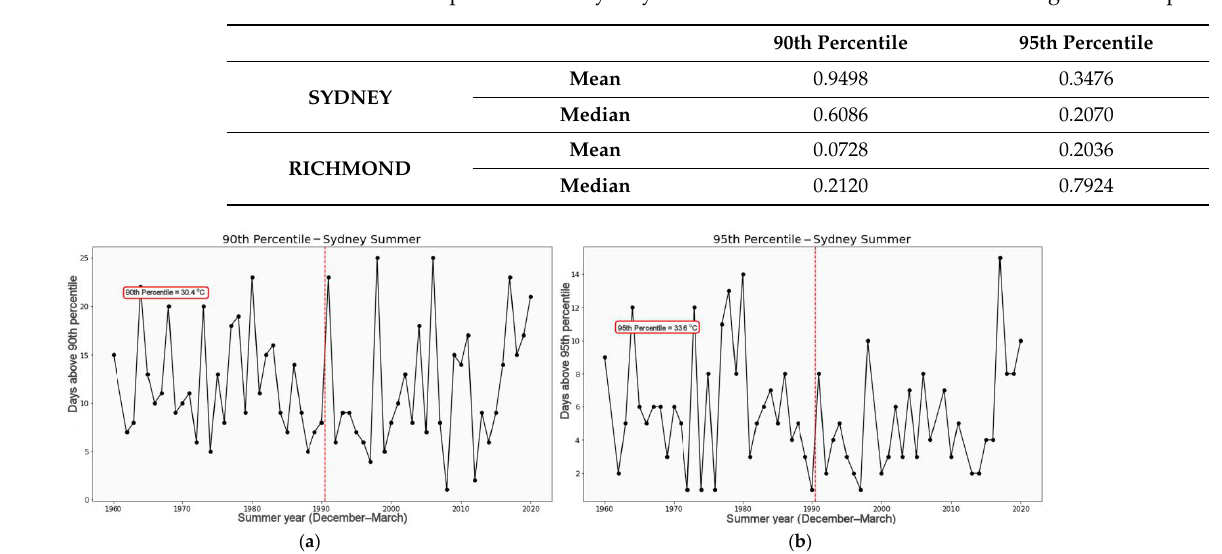
Table 4. Total number of days above the 90th and 95th percentile for Sydney and Richmond. The percentile values are computed using the first climate period. Figure 4. Number of days above the ( a ) 90th percentile and ( b ) 95th percentile across the timeseries for Sydney. The red outlined box denotes the percentile value that is used as the baseline marker and the dotted red line splits the two climate periods.